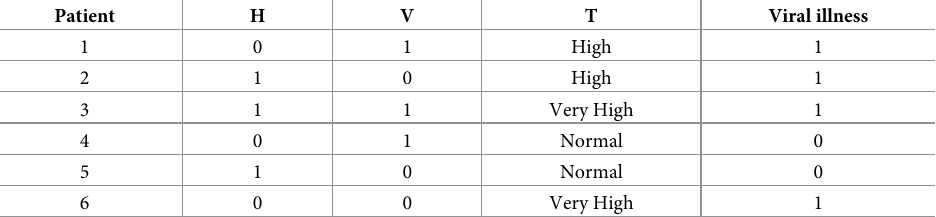
Table 4. A Viral Illness information system.